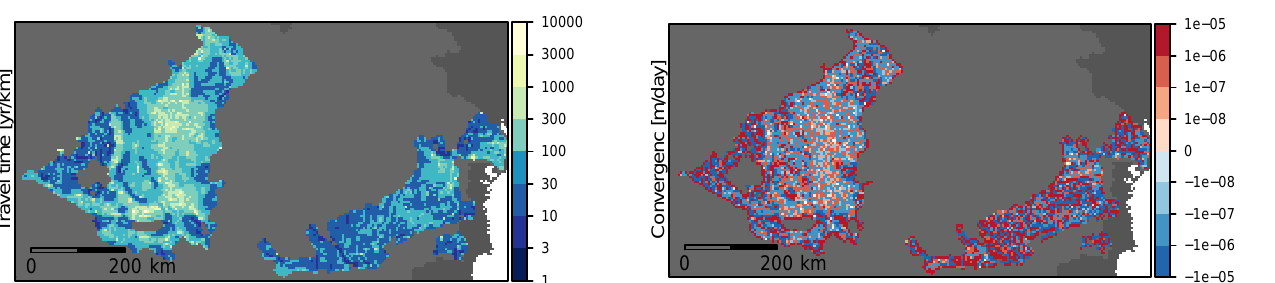
Positive (red) values are divergent areas, where there is a net groundwater export. Negative (blue) values are convergent areas, with a net groundwater